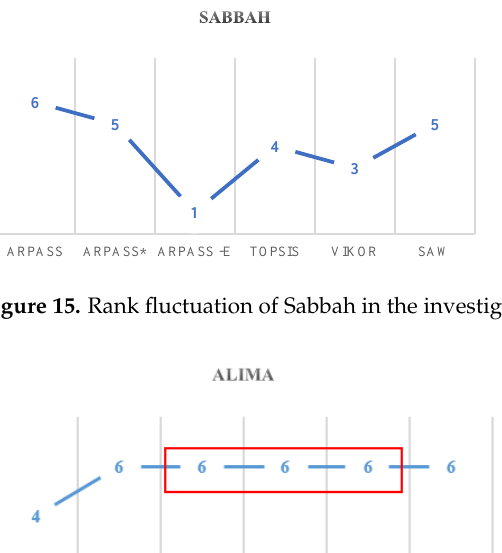
Figure 14. Rank fluctuation of Damdaran in the investigated MCDM methods.